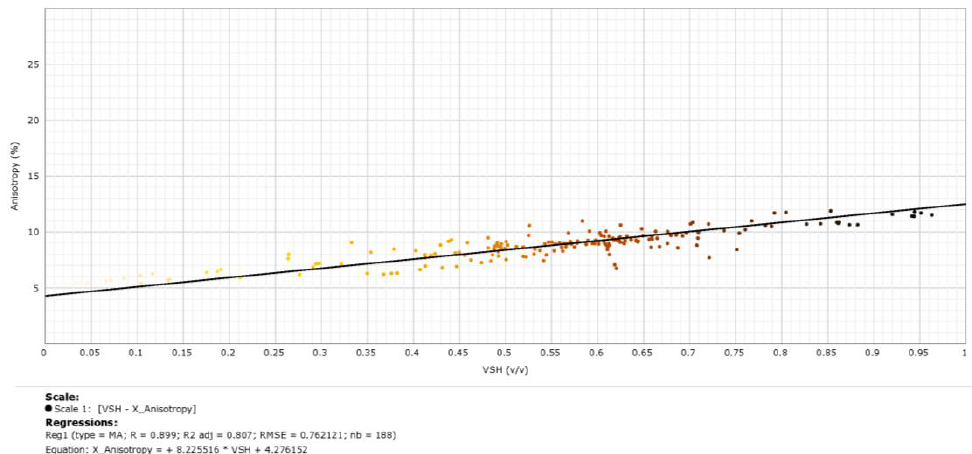
Figure 12. Cross-plot from the validation well showing residuals (difference between the dipole acoustic anisotropy and the calculated anisotropy) on the (x-axis) and resistive fracture frequency (y-axis), after resampling at 25 feet. The cross-plot is colored by VSH (shale volume fraction) values, with lower values in the lighter colors (carbonates) and higher values in the darker colors (shales). The sample size of the dataset (nb) = 166. The correlation (R) between the predictor variable VSH and the response variable anisotropy is 0.9.